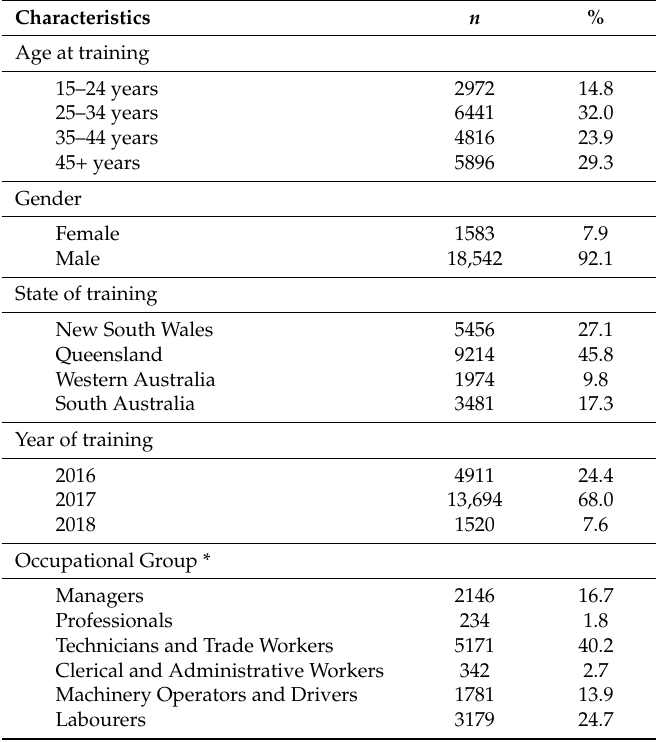
Table 1. Sample characteristics (total n = 20,125).